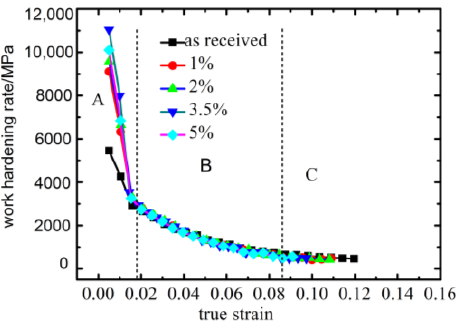
Figure 10. Three stages of work hardening rate in prestrained specimens after annealing: Sharp decrease in stage A, moderate decrease in stage B and slow decrease in stage C.